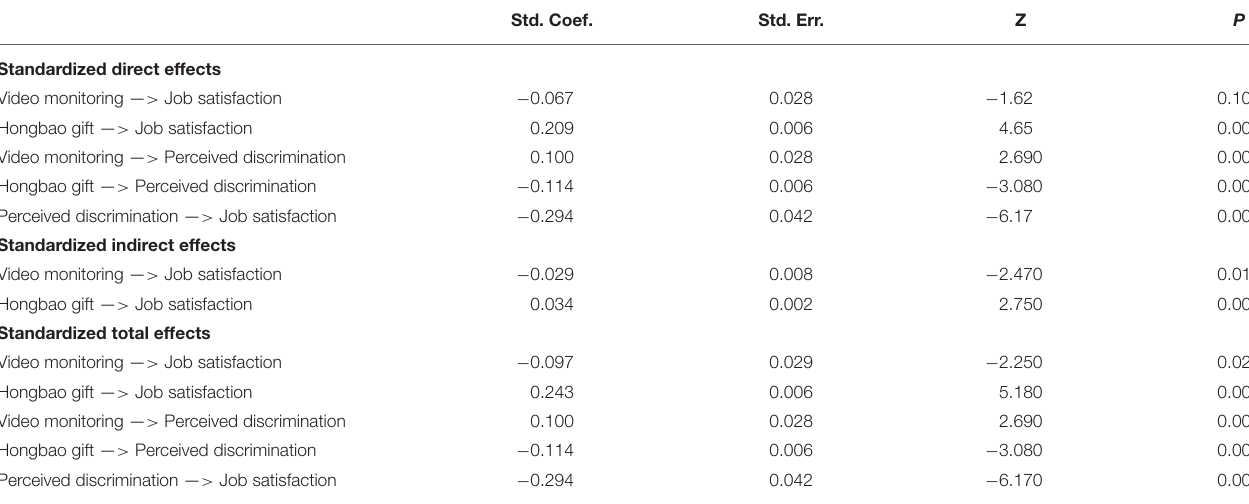
TABLE 3 | Standardized direct effects, indirect effects, and total effects of hongbao gifts, video monitoring, and perceived discrimination on the job satisfaction of domestic workers.